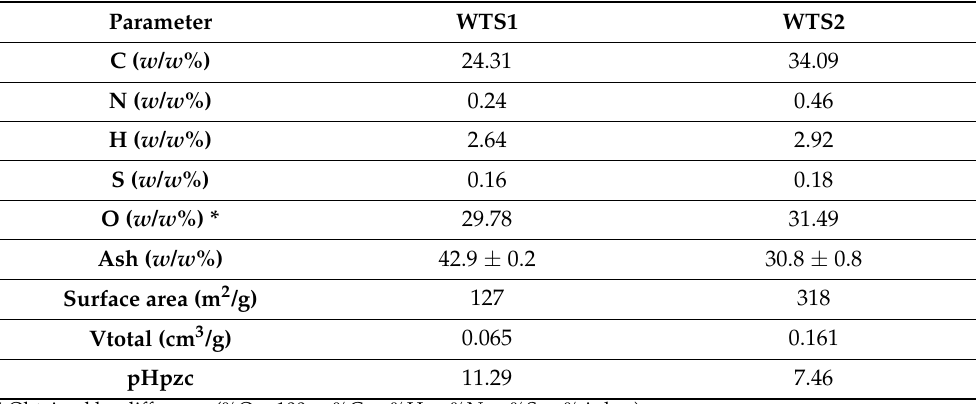
Table 1. Elemental analysis, ash content, pH at the point of zero charge (pHpzc) and textural parameters of the selected drinking water treatment sludges (WTSs). The values presented for the ash content correspond to the mean of duplicates ( X ± σ , n =